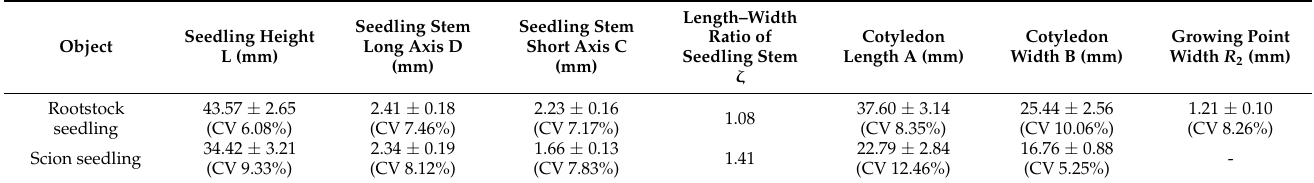
Table 1. Morphological parameters of seedlings.